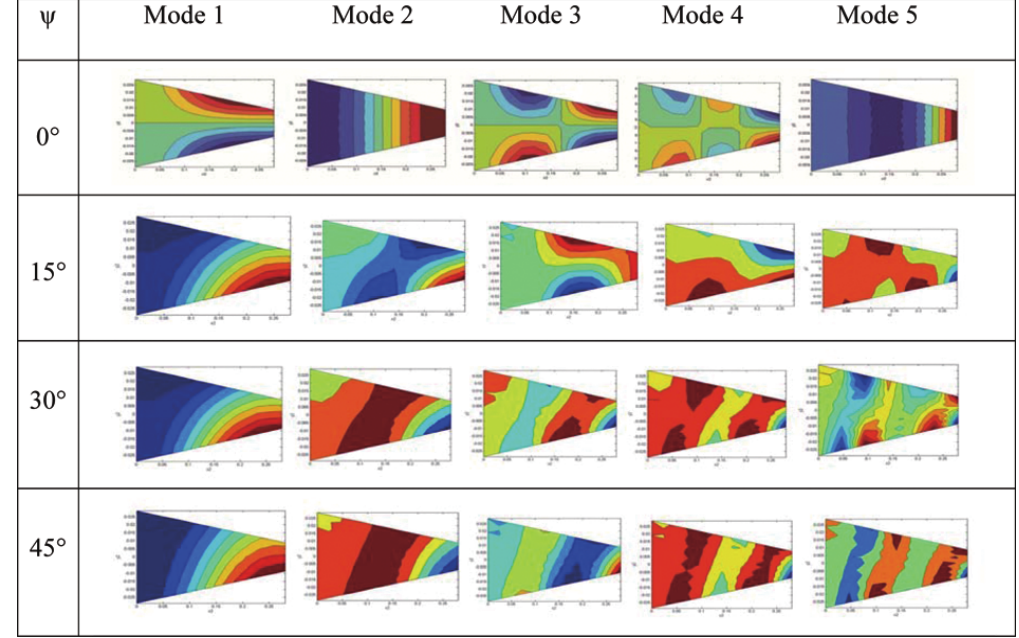
Fig. 7. Effects of twist angles on mode shapes for NDFF of symmetric six layered [0 ◦ /90 ◦ /0 ◦ /0 ◦ /90 ◦ /0 ◦ ] graphite-epoxy cross-ply composite shallow conical shells with mid-plane delamination at stationary condition, considering h = 0.0004, s/h = 1000, L/s = 0.7, d/L = 0.5, ν = 0.3, θ o = 45 ◦ , θ v = 20 ◦ . non-dimensional fundamental frequencies of symmetric cross-ply laminates are identi fi ed to be higher than non- dimensional fundamental frequencies of anti-symmetric cross-ply laminates. The percentage difference between maximum and minimum relative frequencies at stationary condition is found 21.2% for both symmetric and anti- symmetric cross-ply